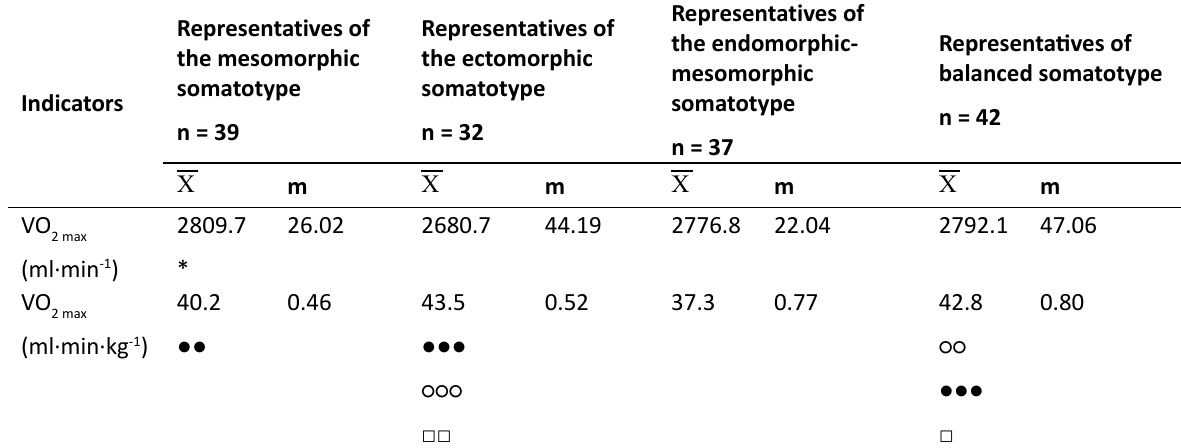
Table 1. Maximum oxygen consumption of men with different somatotypes aged 25-35